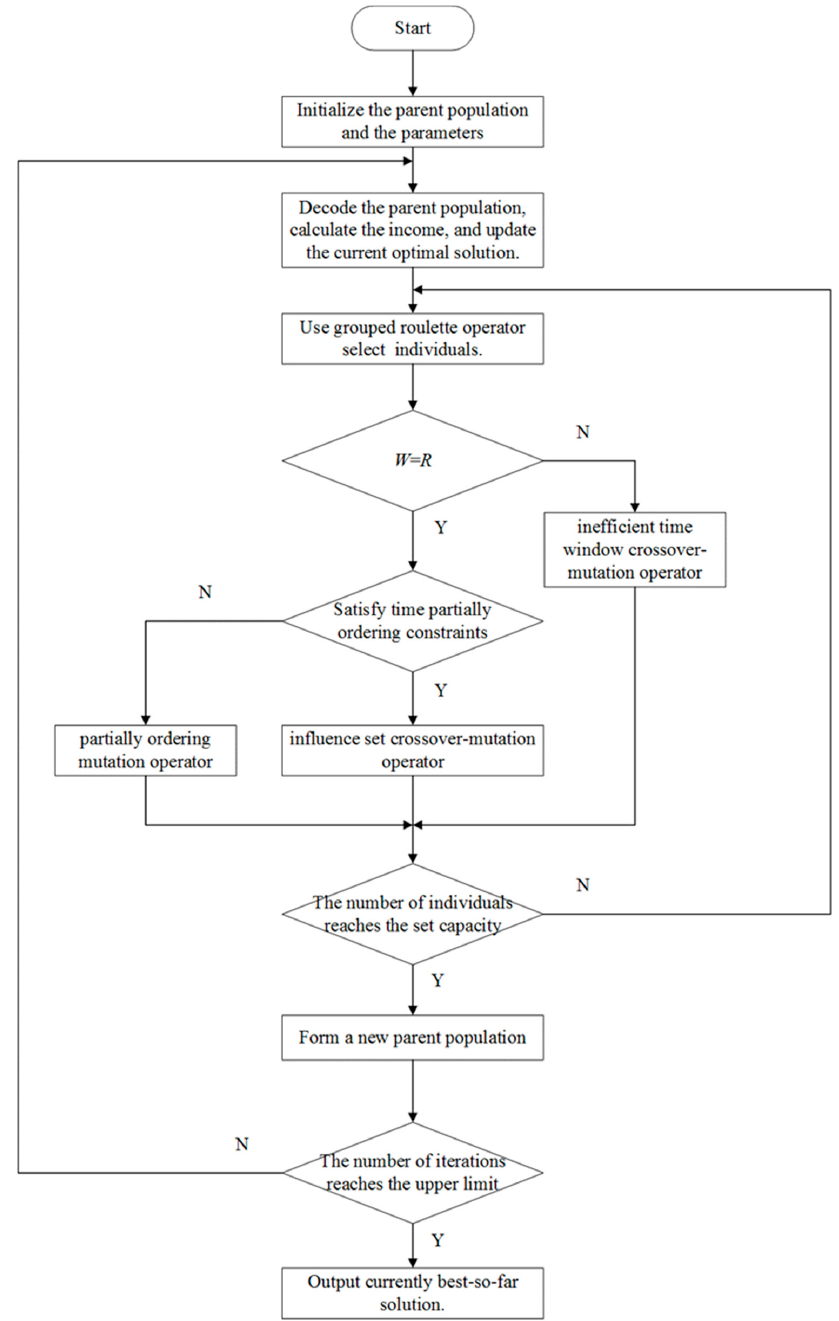
Figure 4. The flowchart of the improved genetic algorithm.